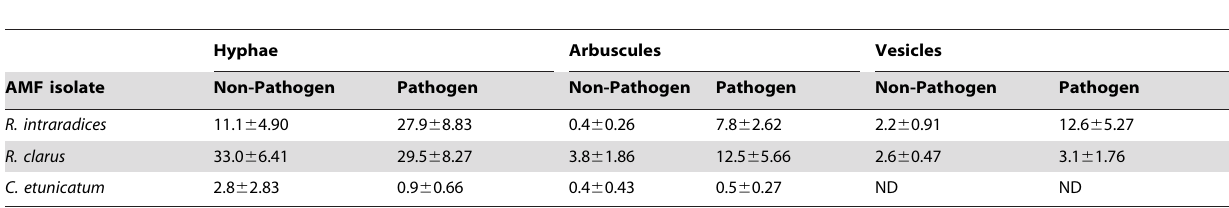
Table 1. Percentage of root length colonized by each AMF isolate at the single diversity level, either in the presence or absence of the pathogen R. solani .